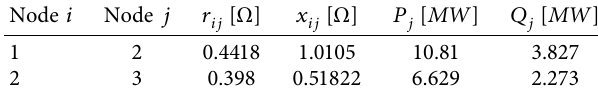
Table 1: San Andres distribution network